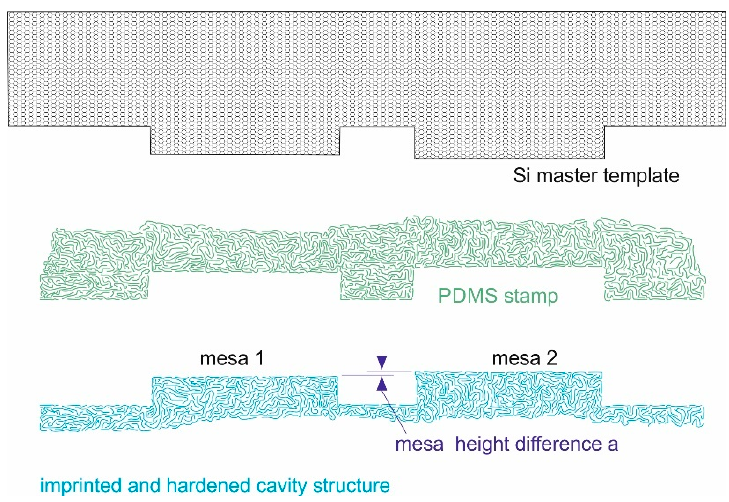
Figure 28. Cross sections of schematic surface profiles. The crystalline structure of the Si master template is visualized by the periodic honey-comb structure ( top ). The master template is replicated in PDMS and rotated by 180°, as shown in green ( center ). The schematic includes a possible arrangement of organic molecules in the PDMS. Subsequently, 3D nanoimprints were performed using this PDMS stamp. After imprinting the resist, hardening the resist and releasing the stamp the blue schematic surface is resulting ( bottom ). The figures do not have the same scale in vertical and lateral direction: differences exist in vertical mesa heights between a = 0.2 nm and 1 nm, lateral mesa widths between 6 µm and 40 µm, and vertical mesa heights between 10 nm and 300 nm.